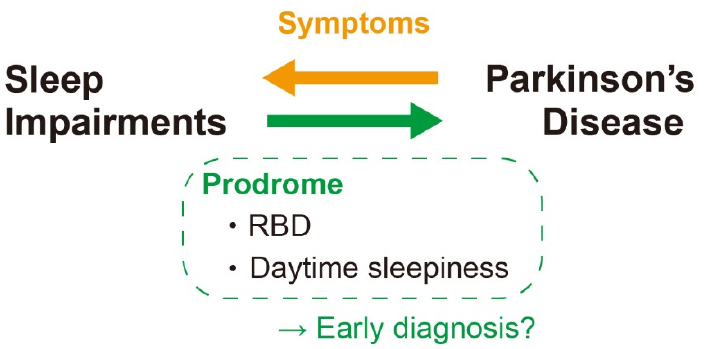
Figure 4. Association between sleep impairments and PD. RBD and daytime sleepiness are two principal sleep impairments in PD patient that is reported to be happened even as a prodrome. It could be useful as a biomarker for the early diagnosis of PD. RBD: REM behavior disorder.